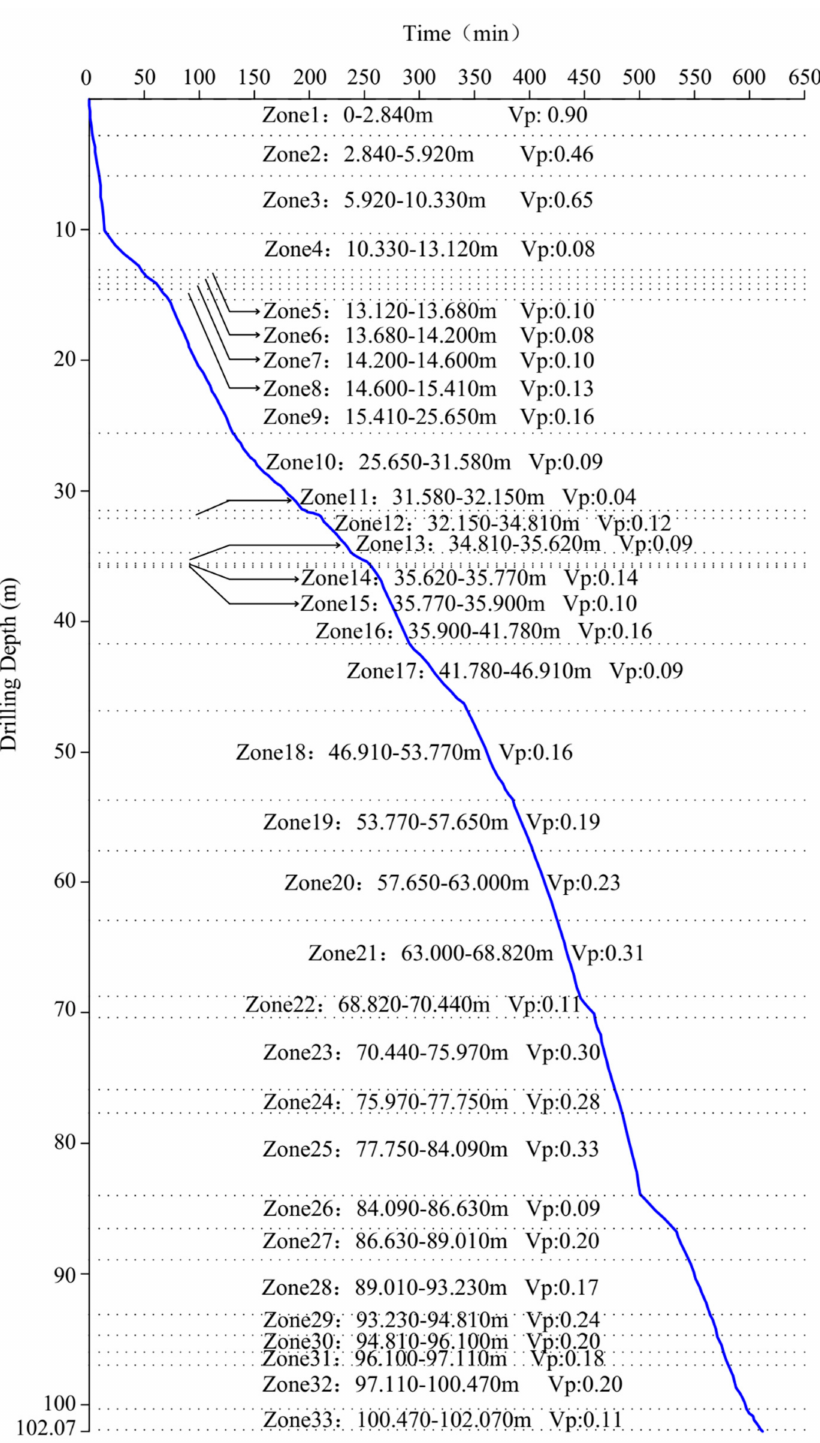
Figure 9. Drilling depth–time curve of the borehole in Yan’an city based on DPM cataloguing. V P is the penetration rate, unit: